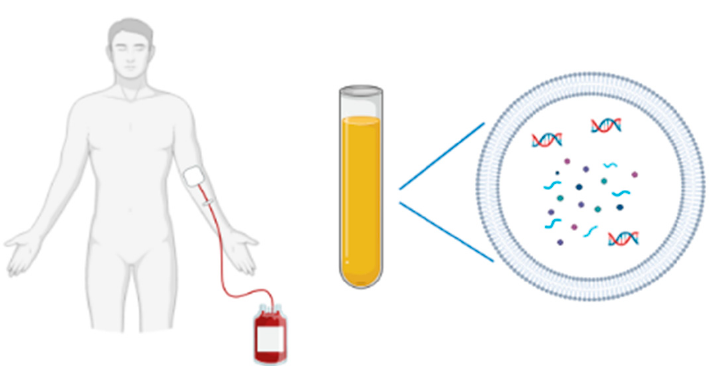
Figure 1. A non-invasive blood sampling allows EV isolation for biomarkers studies (DNA, RNA species, proteins).